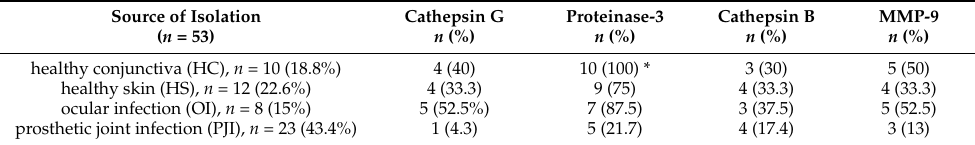
Table 3. Protease-induced biofilm in S. epidermidis isolates from different isolation source. Source of Isolation ( n = 53) healthy conjunctiva (HC), n = 10